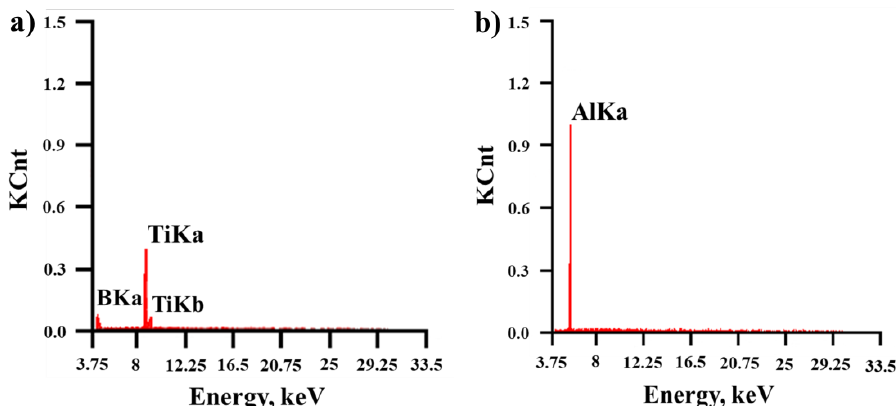
Figure 8. Qualitative elemental analysis of the structural regions of the SHS products shown in Figure 7: region 1 ( a ) and region 2 ( b ).